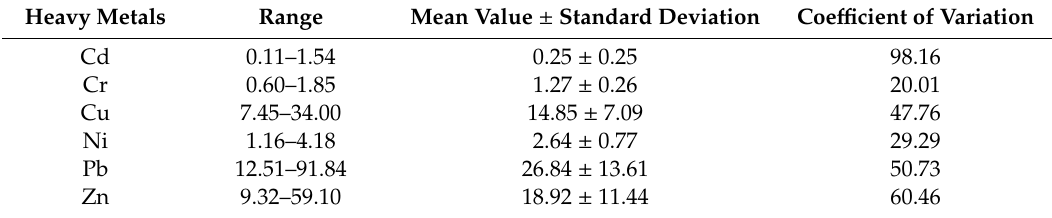
Table 5. The available concentration of six heavy metals in the